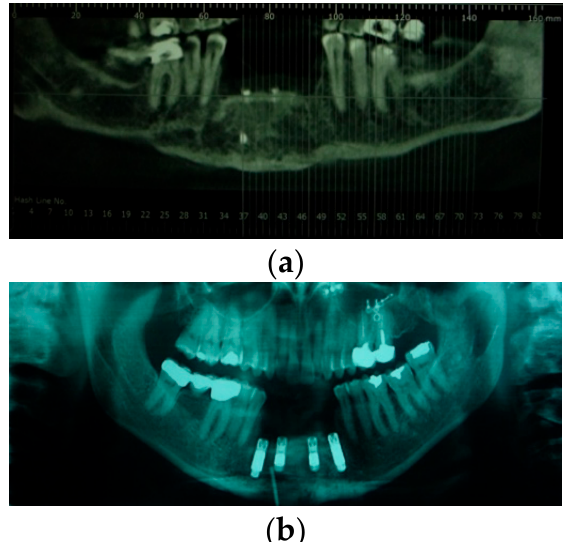
Figure 2. ( a ) Radiography imaging before prosthetic rehabilitation; ( b ) Radiography imaging after implant surgery.